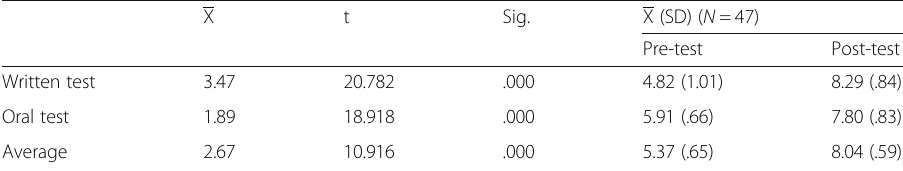
Table 3 EFL learners ’ LC - Summative test (Paired samples t-test)